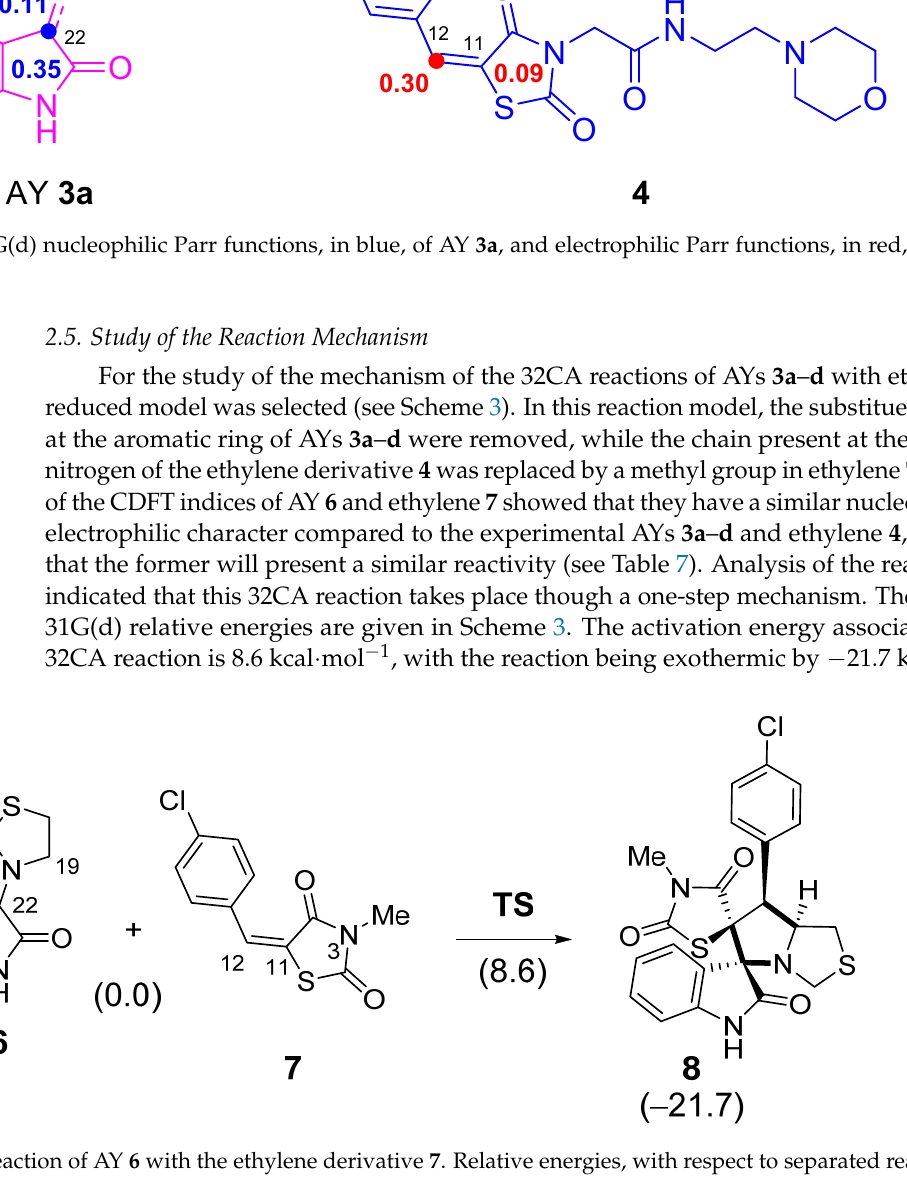
Figure 9. B3LYP/6-31G(d) nucleophilic Parr functions, in blue, of AY 3a , and electrophilic Parr functions, in red, of the ethylene derivative 4